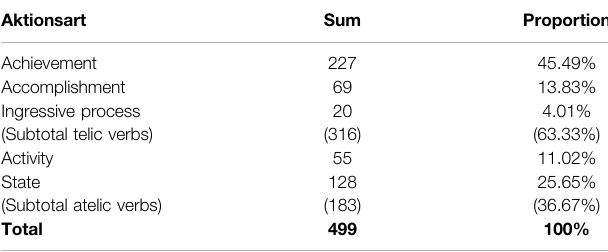
TABLE 4 | Aktionsart distribution of imparfait verbs in the 25 texts with the highest proportion of imparfait verbs (data from Emolex). Aktionsart Sum